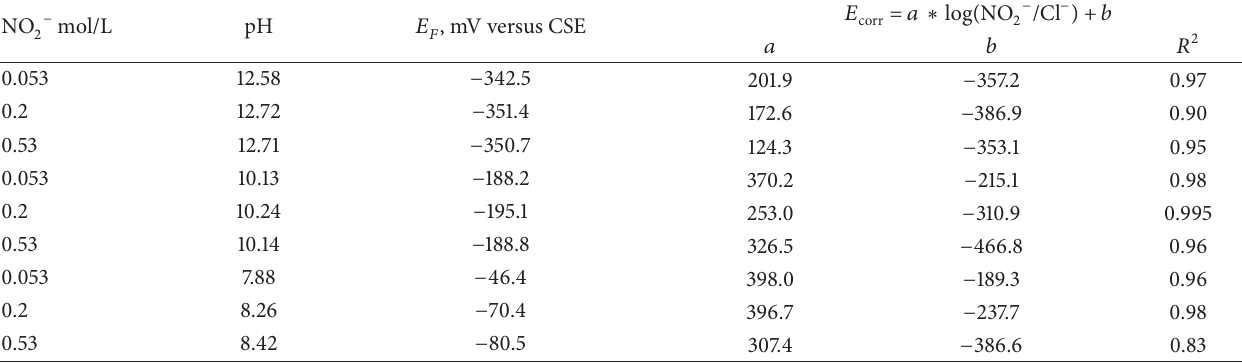
and log(NO 2− /Cl − ). corr